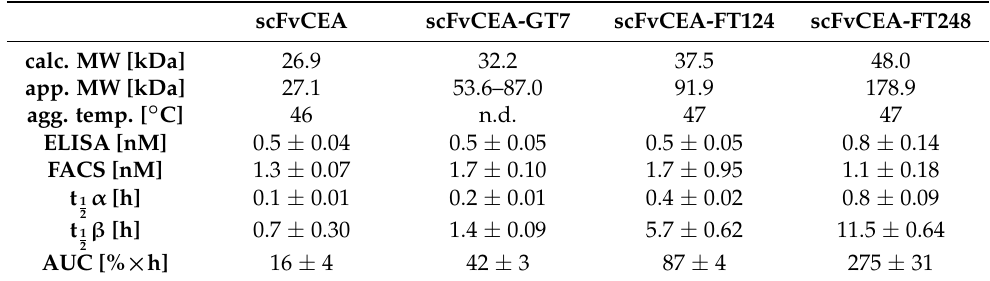
Table 1. Biochemical, binding, and pharmacokinetic properties of scFv-based molecules. Mean ± SD, n.d.: not determined, n =